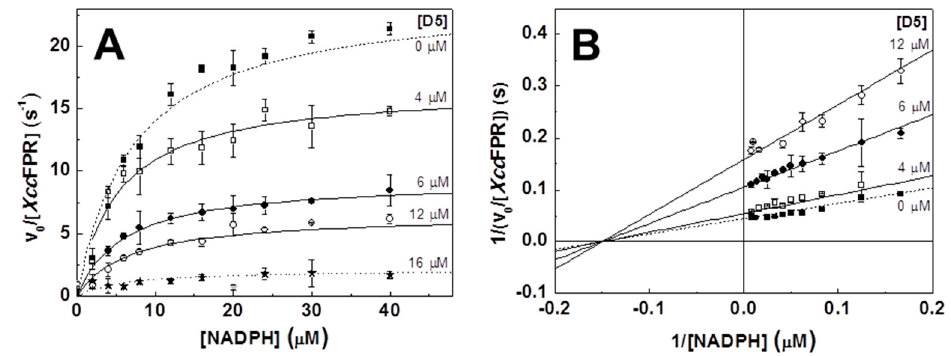
Figure 4. Mechanisms of the D5 Xcc FPR inhibitors. ( A ) Michaelis-Menten plots and ( B ) Lineaweaver-Burk representations with global fit for non-competitive inhibition. Reaction rates were measured in 50 mM Tris/HCl pH 8.0 containing 20 nM Xcc FPR, 95 μ M DCPIP and 0–50 μ M NADPH at 25 °C ( n = 3, means ± SD). All samples contained 2% DMSO.